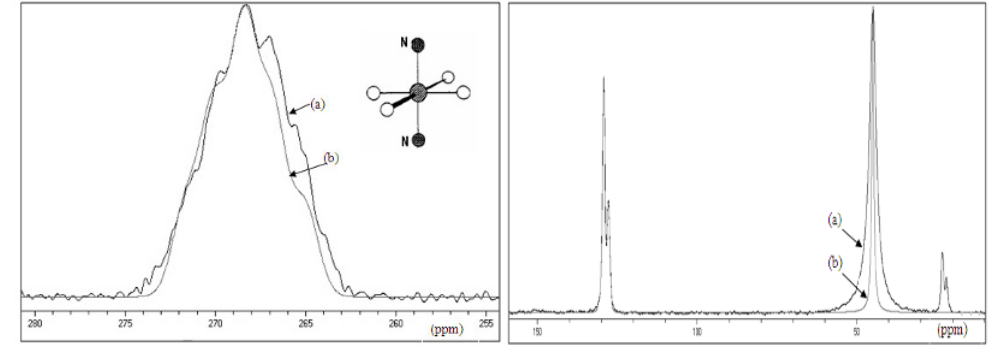
Fig.4. Isotropic region of the 111 Cd MAS NMR spectrum of C 2 H 10 N 2 Cd(SCN) 2 (Cl) 2 having spin-spin coupling of 111 Cd to two 14 N nuclei: (a) experimental spectrum; (b): calculated spectrum.